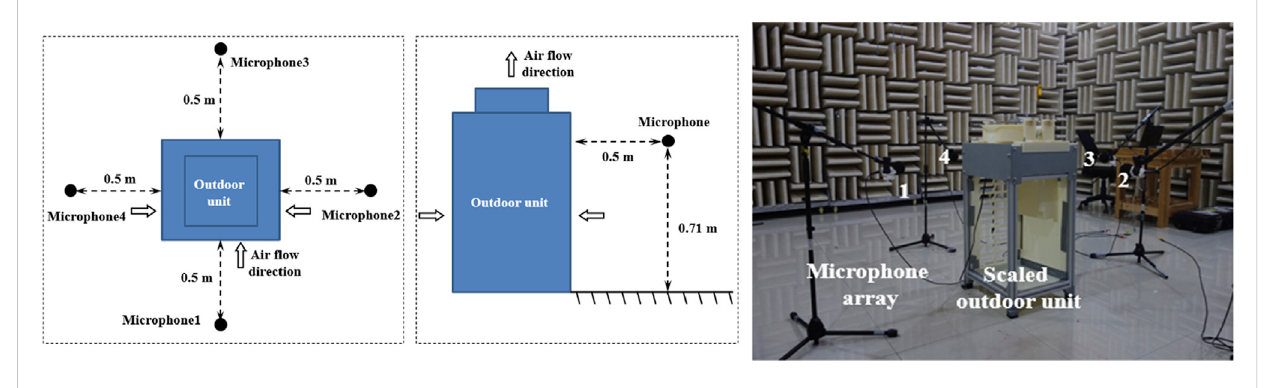
FIGURE 4 Schematic and photograph of the noise test rig.